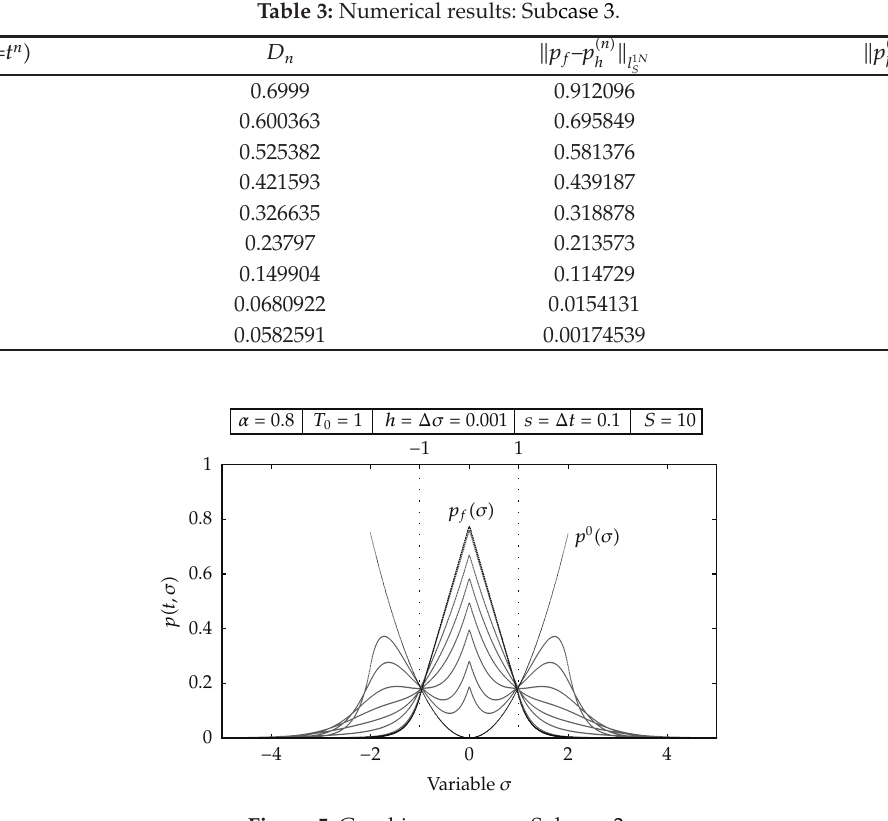
Figure 5: Graphics sequence: Subcase